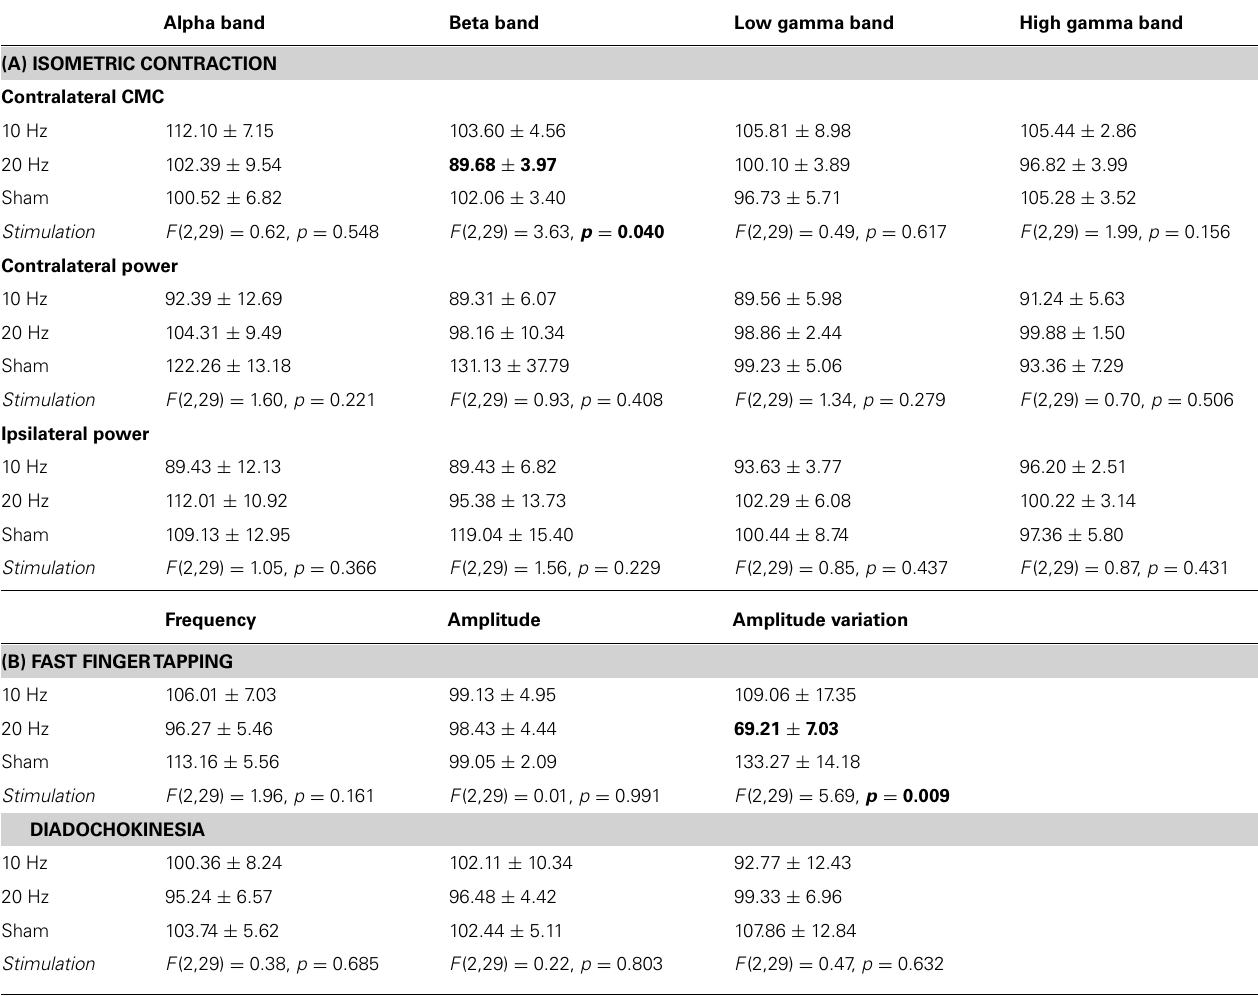
Table 1 | Relative changes to baseline in % (A) of CMC and power (mean ± SEM ) following tACS during isometric contraction and (B) of fast finger tapping and diadochokinesia in PD